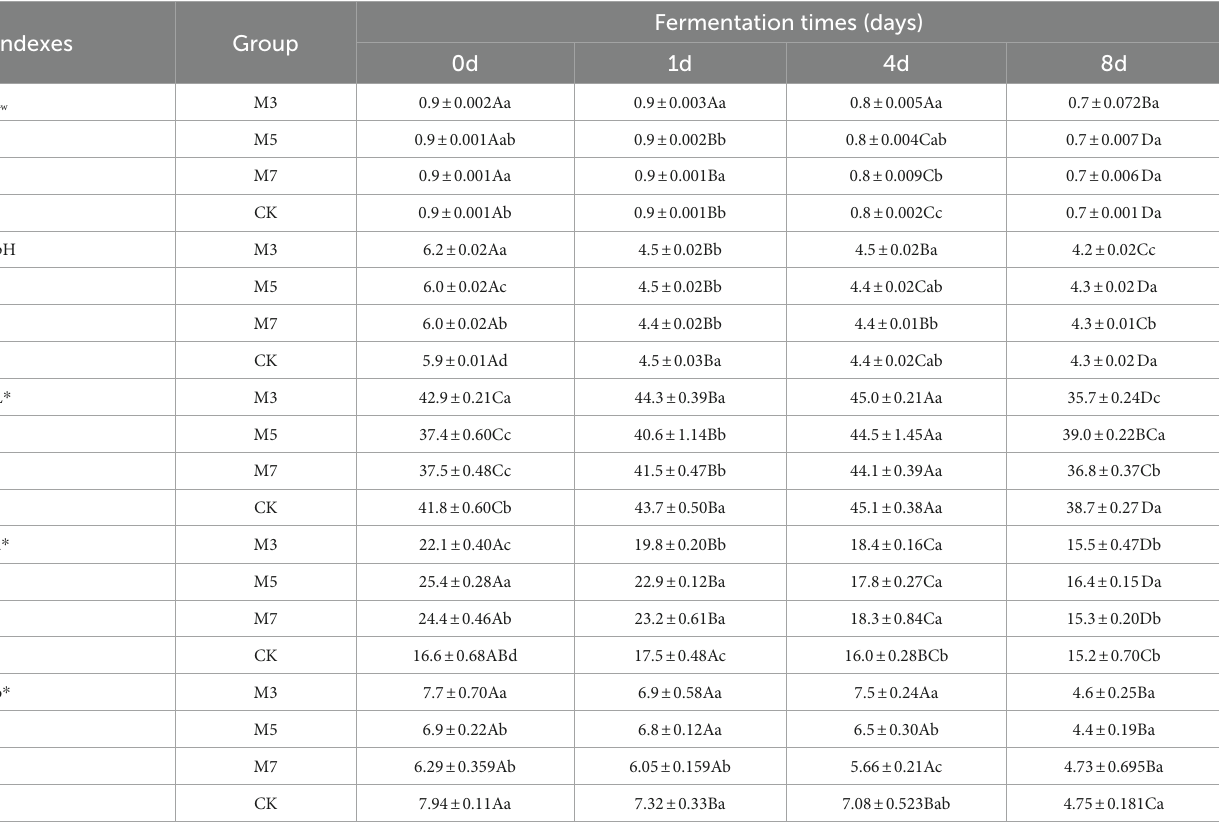
TABLE 1 Physicochemical properties of fermented sausages.